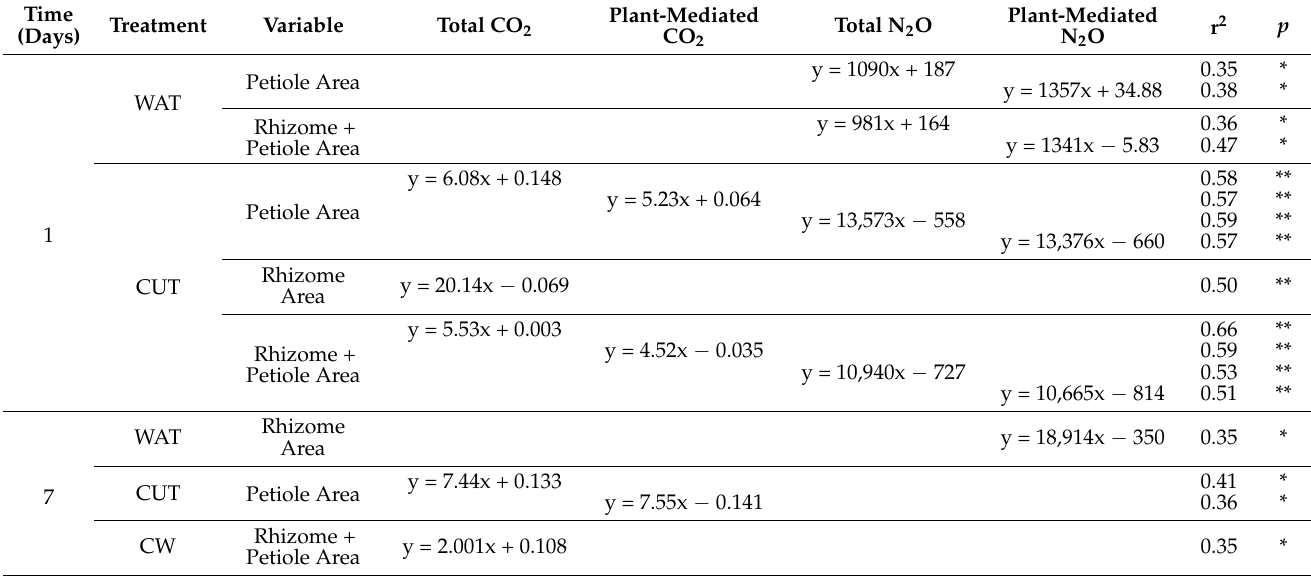
Table 2. Correlations between plant parameters with CO 2 and N 2 O fluxes in experiments conducted on G. tinctoria at UCD’s Rosemount Environmental Research Station glasshouse, Dublin, Ireland, July–August 2017. Legend: 0, 1, 7, and 30 refer to before, 1, 7, and 30 days after the application of treatments; WAT = plants subjected to flooding; CUT = plants that had the leaves cut from the petioles but were watered normally; CW = plants where leaves were removed and were also subjected to rhizome flooding. * p < 0.05; ** p <